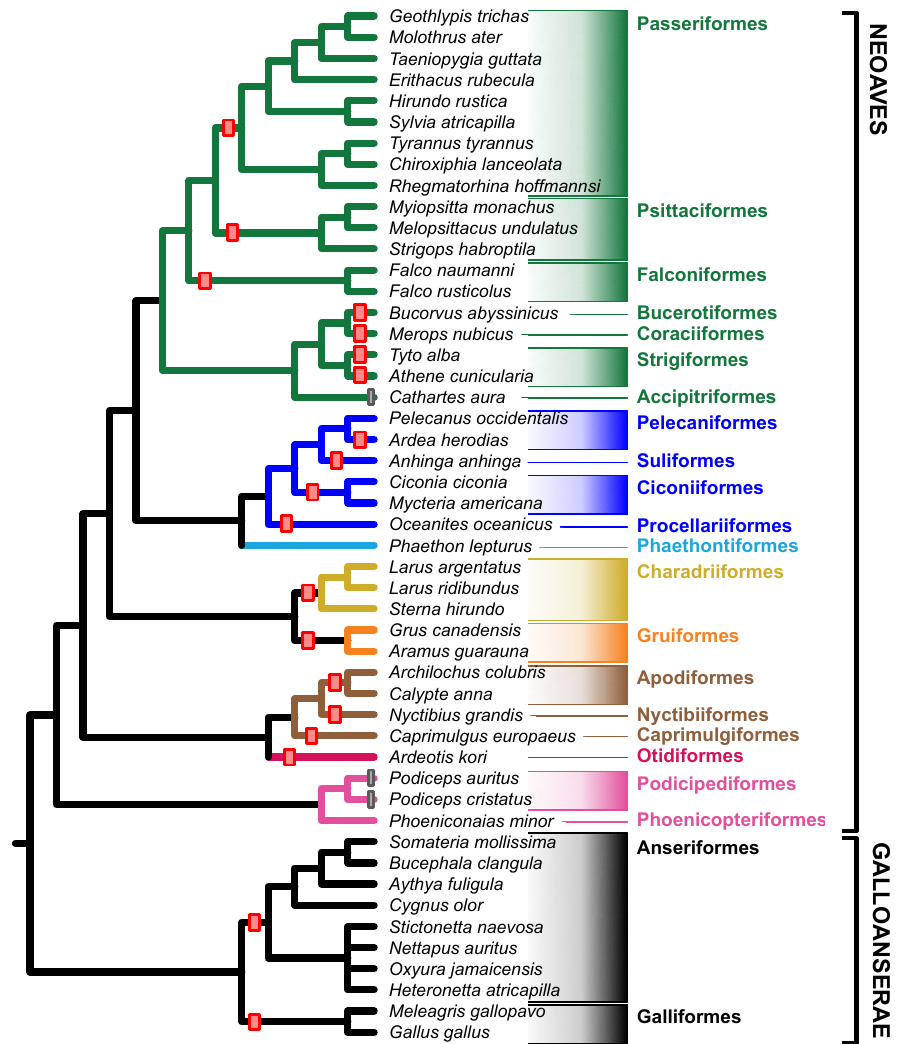
Figure 4. Avian phylogenetic relationships among Neognathae (based on Kimball et al. [67] and using the IOC world bird list v. 11.2 [49]) showing estimated barriers to recombination at the ATP5F1A locus. Red bars on branches indicate cases where gametologs are clearly distinct. Gray bars are cases where gametologs are similar, but based on Suh et al. [22] may have ceased recombining. For three species (White-tailed Tropicbird, Phaethon lepturus , Lesser Flamingo, Phoeniconaias minor and Brown Pelican, Pelecanus occidentalis ), we suggest that recombination may be occurring. Colors identify major clades and are those used in Braun and Kimball [66].